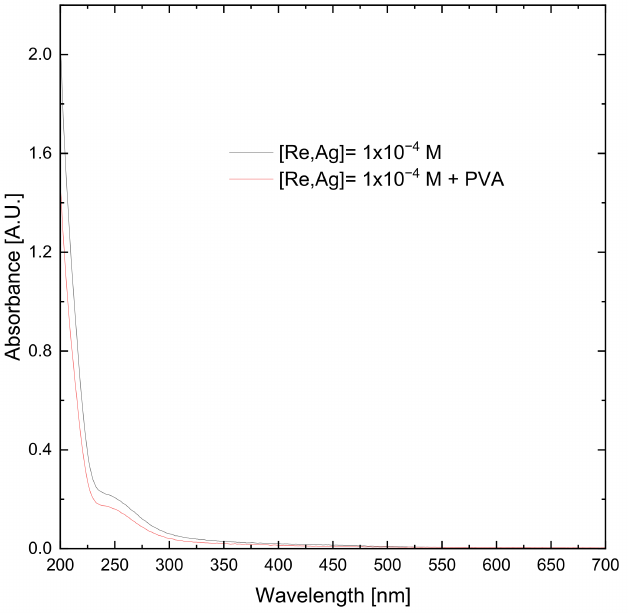
Figure 8. UV–Vis spectra of solutions of synthesized silver–rhenium nanoparticles in the presence and absence of a stabilizer (PVA), at both silver and rhenium concentrations of 1 × 10 − 4